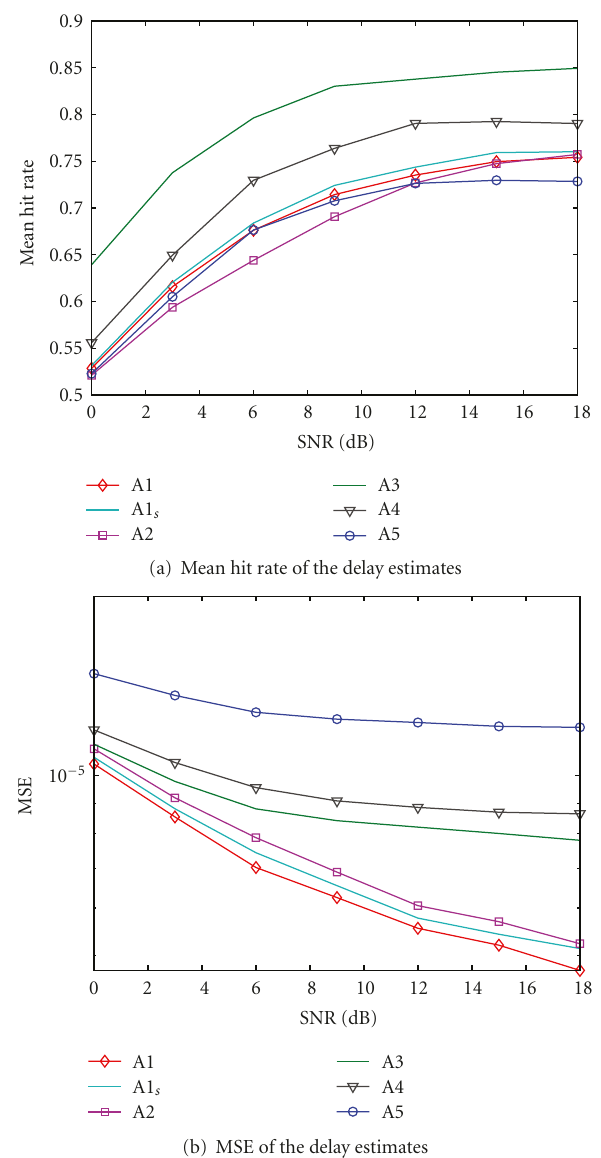
Figure 5: The averaged hit rate (a) and MSE (b) versus the SNR in the algorithms A1–A5 when p = 10, L = 50, and M = 60 for A1, A1 s , A3, M = 120 for others. The parameters of harmonics are from the IEEE channel model.